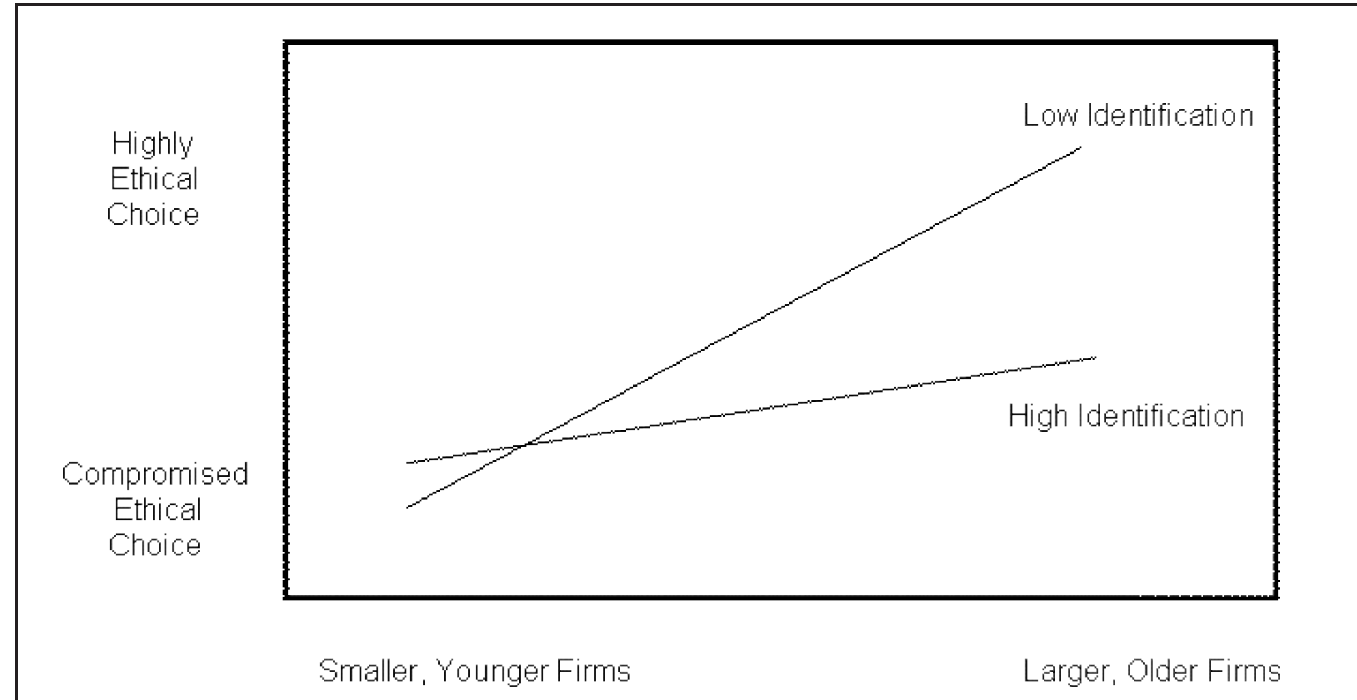
Figure 2. Interaction of Identification with Size/Age on Ethical Compliance